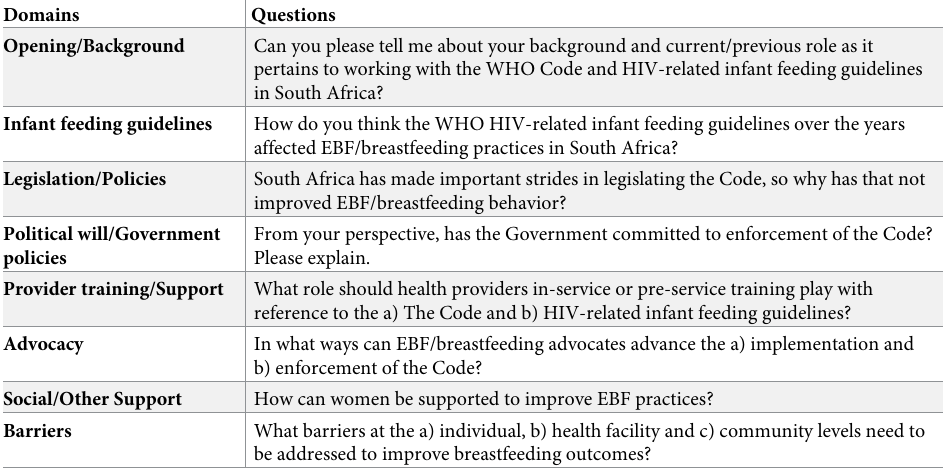
Table 1. Interview guide: Domains and